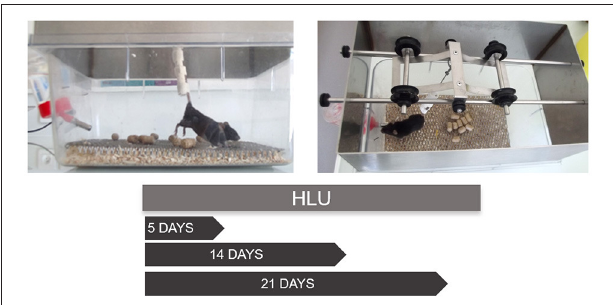
FIGURE 1 | The suspension of the hindlimbs of a C57BL/6J mouse via tail suspension and the usual protocol durations. The suspension system consists of the padded rod to which the tail is attached using three tonoplast bandages wrapped at a distance from each other to not cover the tail completely. The rod is then hooked to a freely rotating swivel fixed to a pulley sliding on a roller axis to allow the mouse to freely rotate in 360 ◦ axis. The mouse is singly caged and allowed to move on its forelimbs with the support of the grid below. The angle of unloading is maintained at 30 ◦ from the ground. The periods of suspension may vary based on the experimental requirements. The different periods of suspension allow one to follow the kinetics of bone adaptation to unloading. At all-time points adaptation can be identified at different levels: molecular (gene expression profiling), cellular (histomorphometry) and tissular (X-ray tomography). Although tail traction with orthopedic tape is the preferred method of suspension, other methods including use of a body harness to stimulate partial weight bearing have been illustrated (Wagner et al.,